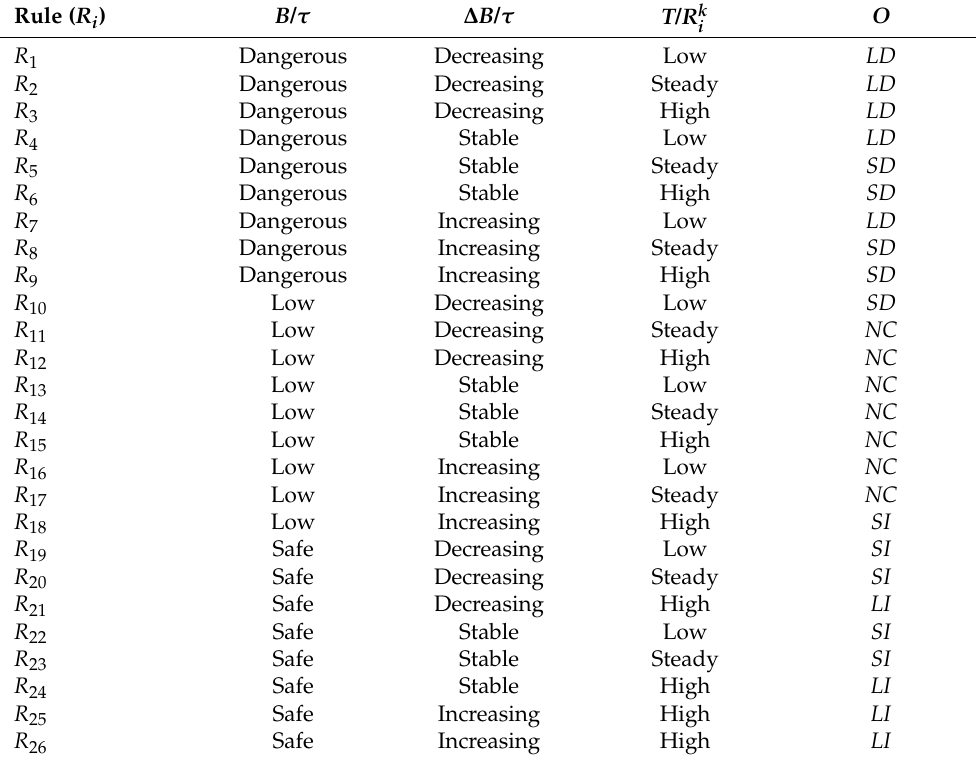
Table 1. FDASH fuzzy